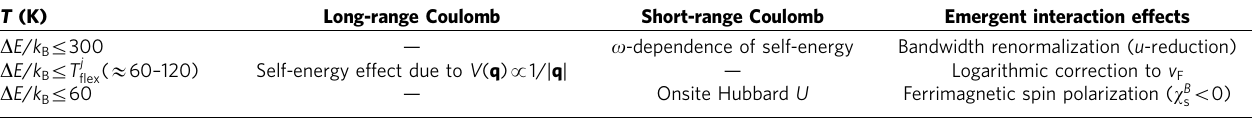
BEDT-TTF, bis(ethylenedithio)-tetrathiafulvalene. Here, D E ( ¼ k B T ) indicates the energy range aroundthe gapless point at E F , within which the inter-band thermalexcitationsareeffective(see the inset of Fig.2e). T j flex stands for the peak temperaturein the first derivative of the electron spin susceptibility w j s (Fig. 2e) at the non-equivalent site j ¼ A ( ¼ A ’), B and C in the unit cell (Fig. 1b), o indicates the frequencyand u represents the phenomenological parameter introduced in the RG fit analyses (see the